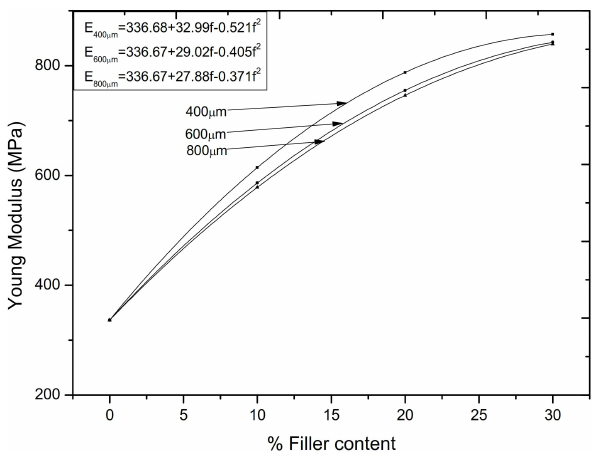
Figure 6: Variation of Young’s Modulus with RH content and particle size